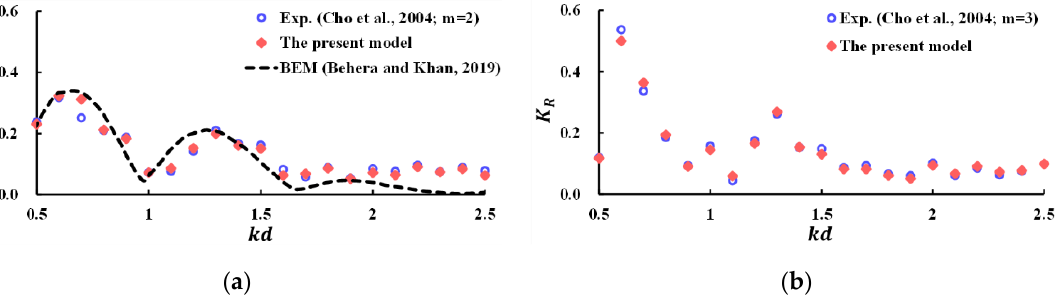
Figure 1. Cho et al. (2004)’s experiment for the wave reflection by the submerged breakwaters.